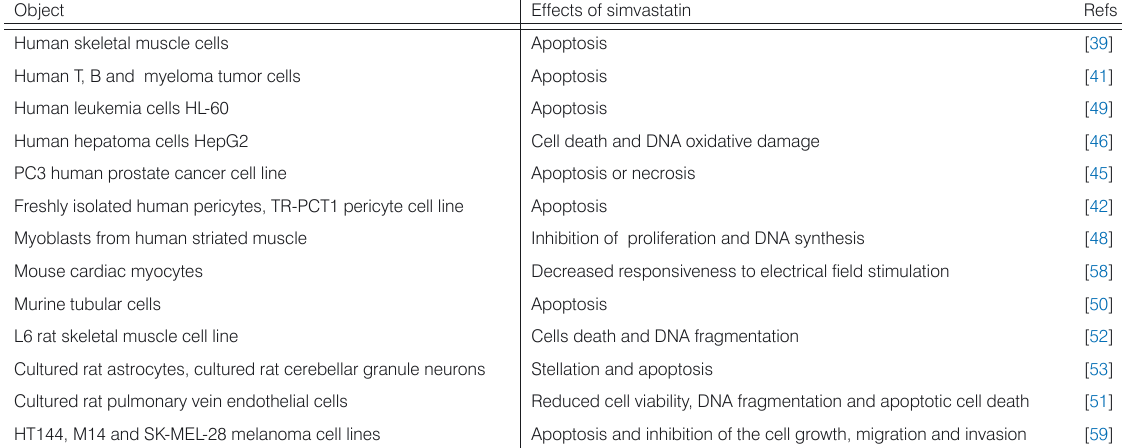
Table 2. Cytotoxicity of